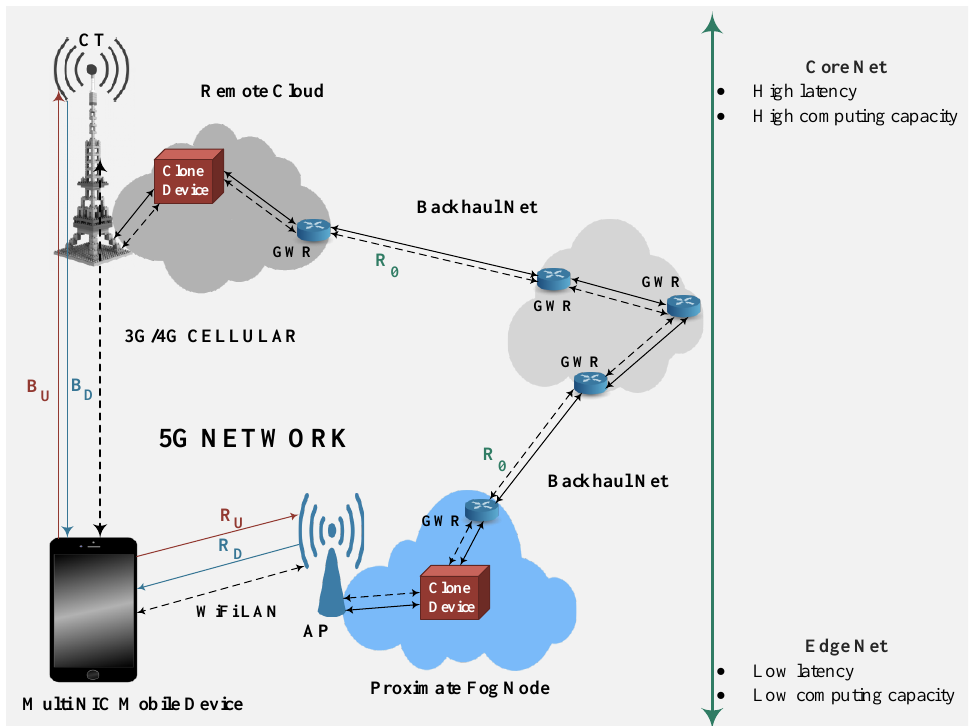
Figure 1. The considered 5G-supported Mobile-Fog-Cloud virtualized infrastructure. WAN: Wide Area Network; LAN: Local Area Network; CT: Cellular Tower; AP: Access Point; GWR: GateWay Router. Single (resp., double)-arrowed paths indicate one-way (resp., two-way) TCP/IP